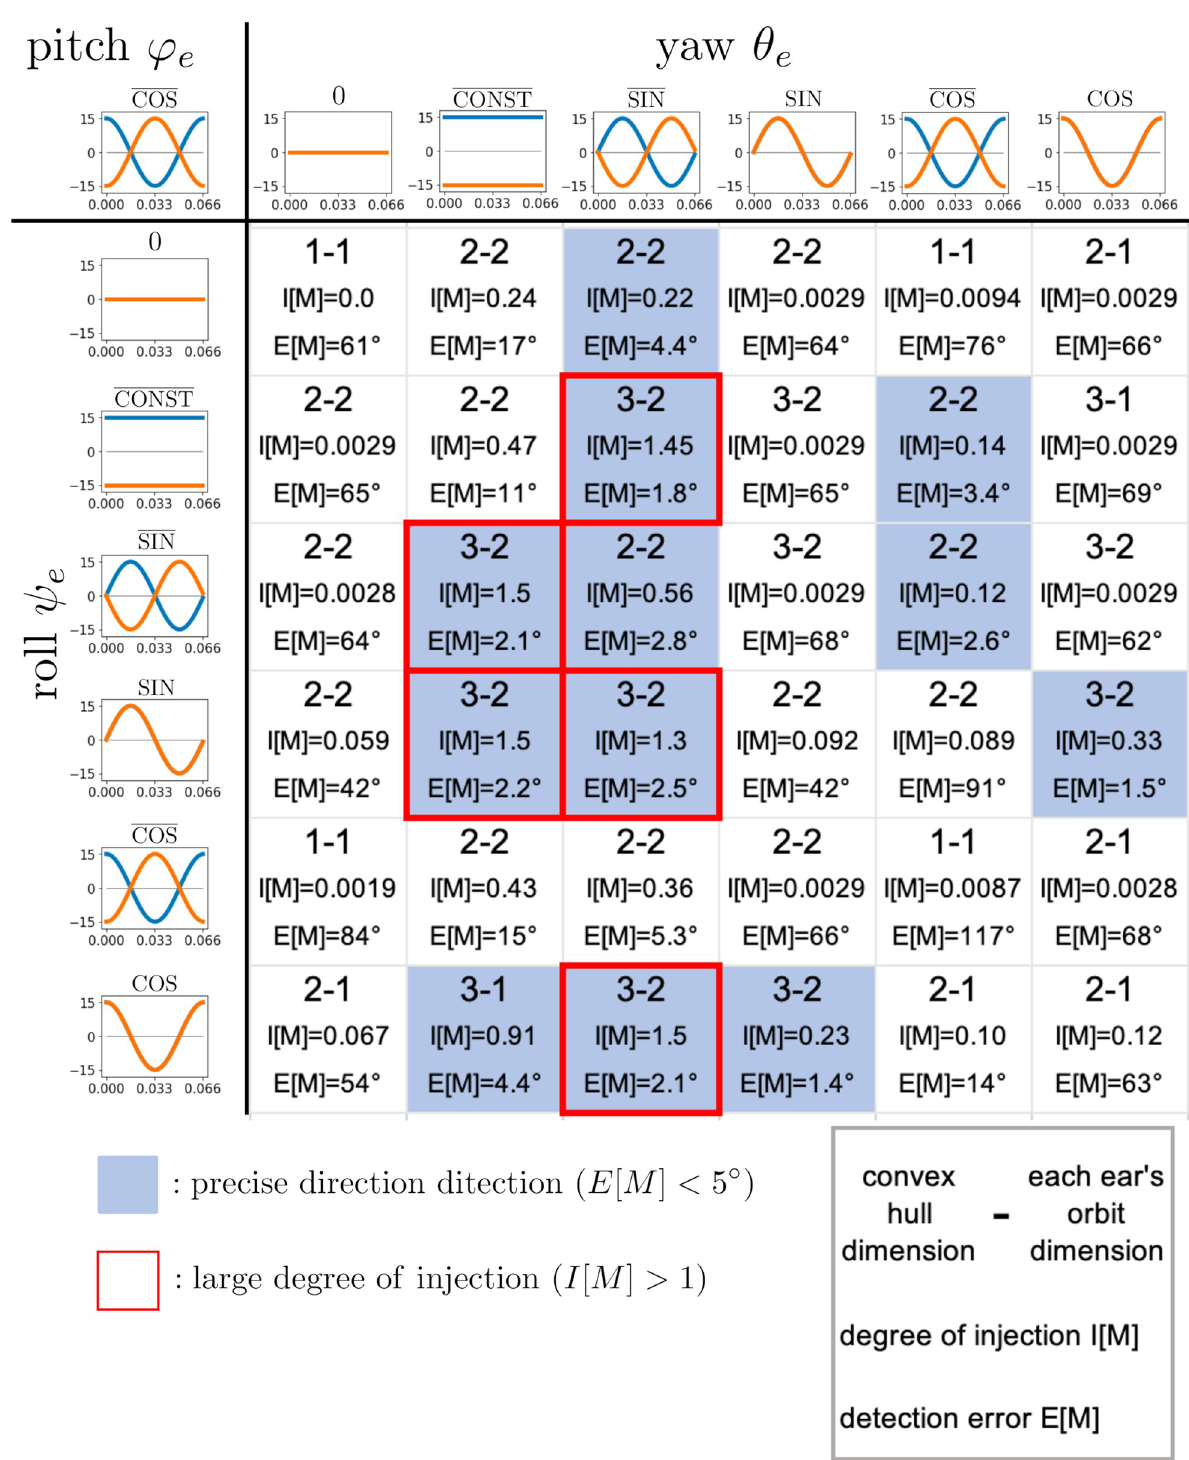
Fig 8. Dimension pairs and direction detection errors for various motion patterns. In each box, the dimension pair of the convex hull and each ear’s orbit is given in the upper part, the degree of injection is given in the middle, and the detection error is given at the bottom. Here, we adopt E [ M ] < 5˚ as the criterion for precise direction detection. The colored boxes indicate that the corresponding motion patterns give precise direction detection. The boxes bounded by red lines correspond to the motion patterns with large degrees of injection ( I [ M ] > 1).